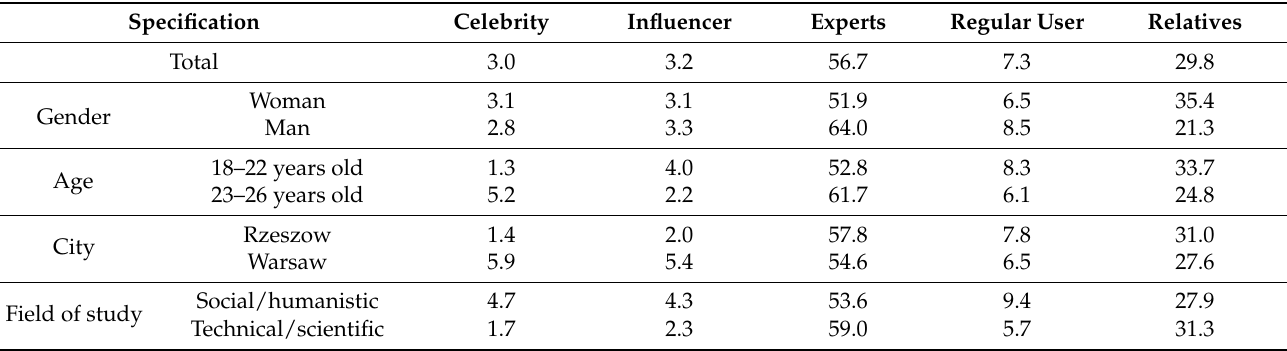
Table 9. The preferences of Generation Z respondents with regard to people who most effectively influence the decision to use green energy (in